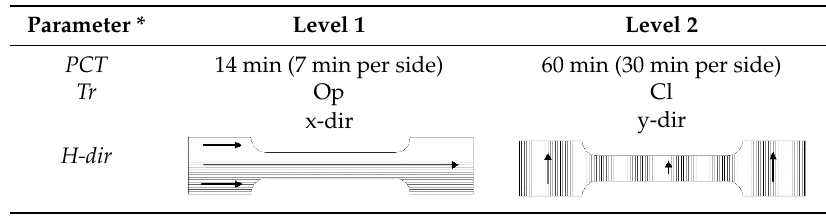
Table 1. Design of experiment (DOE): Considered printing parameters and respective values setting.